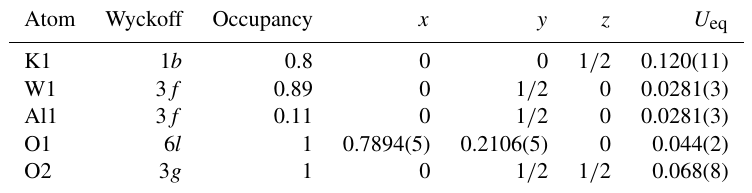
Table 4. Atomic coordinates of